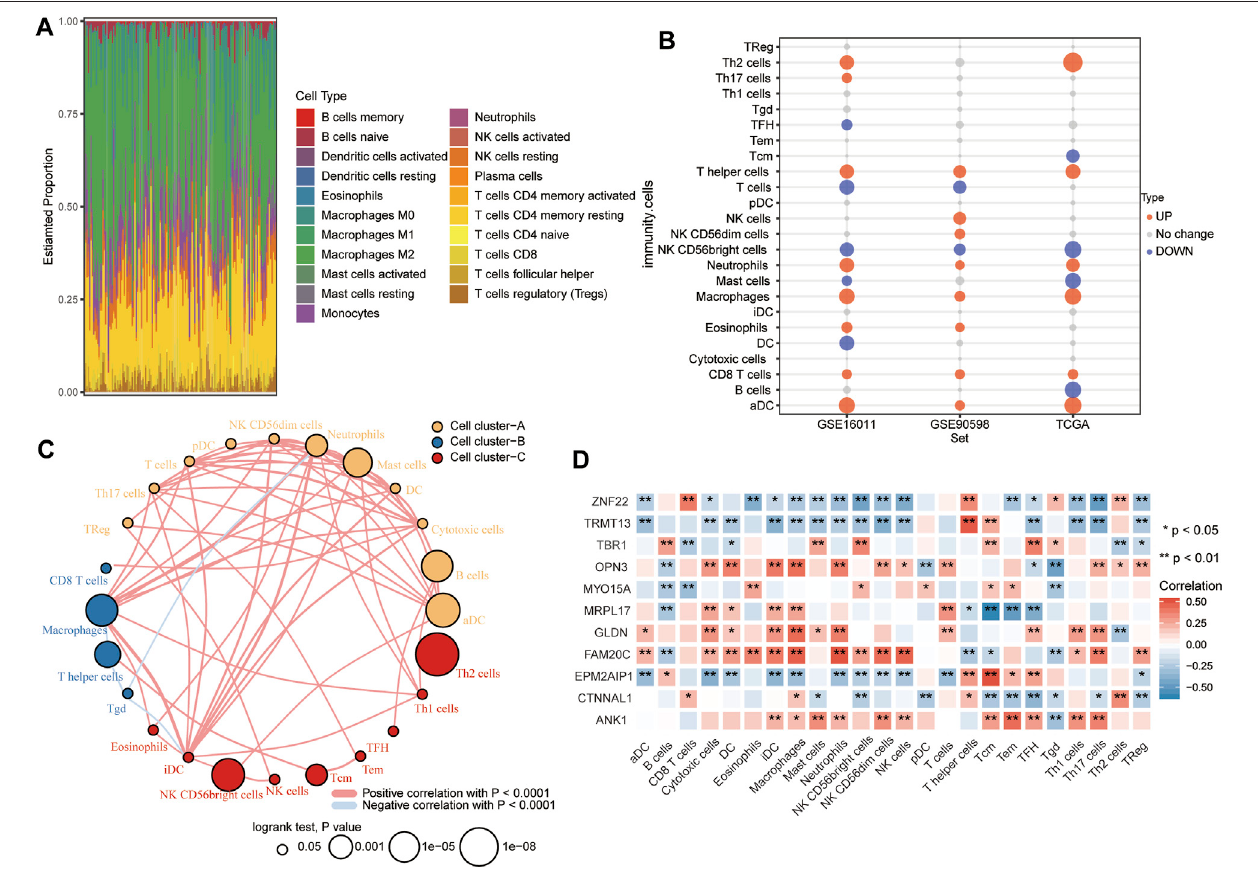
FIGURE 8 | Relationships between RBM8A expression and tumor in fi ltration by different types of immune cells in GBM. (A) Proportions of immune cell types in GBM patients in TCGA, as detected by the CIBERSORT algorithm. (B) Levels of in fi ltration by immune cell types in GBM and controls in TCGA, GSE16011, and GSE90598 datasets. (C) Correlation and clustering of tumor-in fi ltrating immune cell types. (D) Correlation between levels of candidate mRNAs and levels of tumor- in fi ltrating immune cell types. * p < 0.05, ** p <